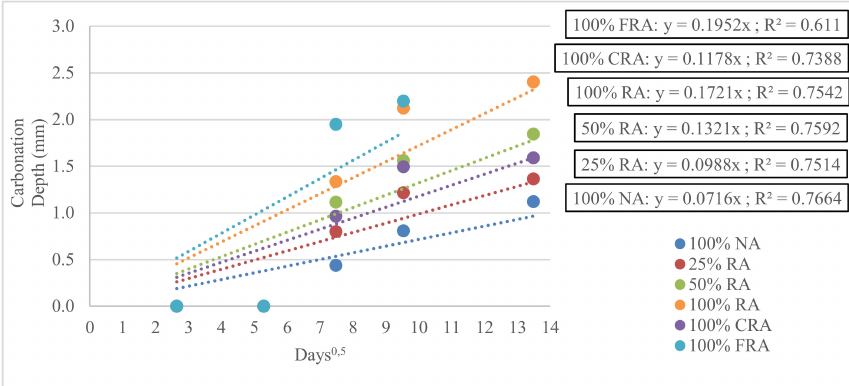
√ t for all mixes.